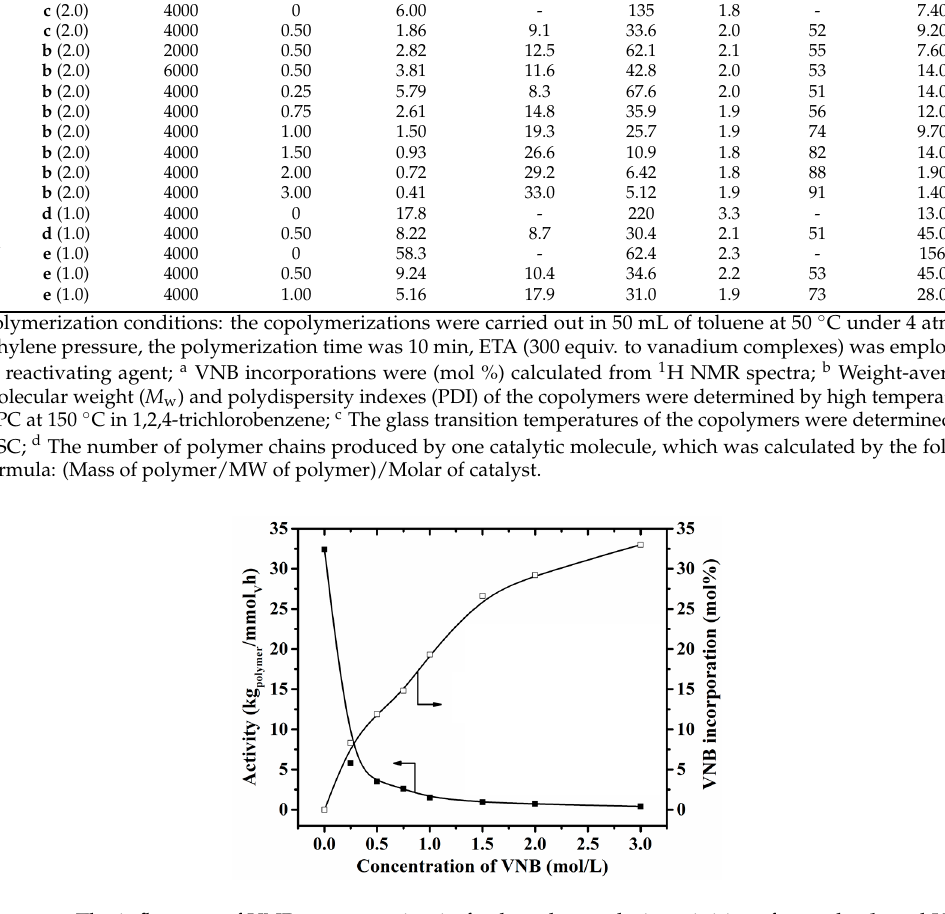
Figure 1. The influences of VNB concentration in feed on the catalytic activities of complex b and VNB incorporations in the copolymers.